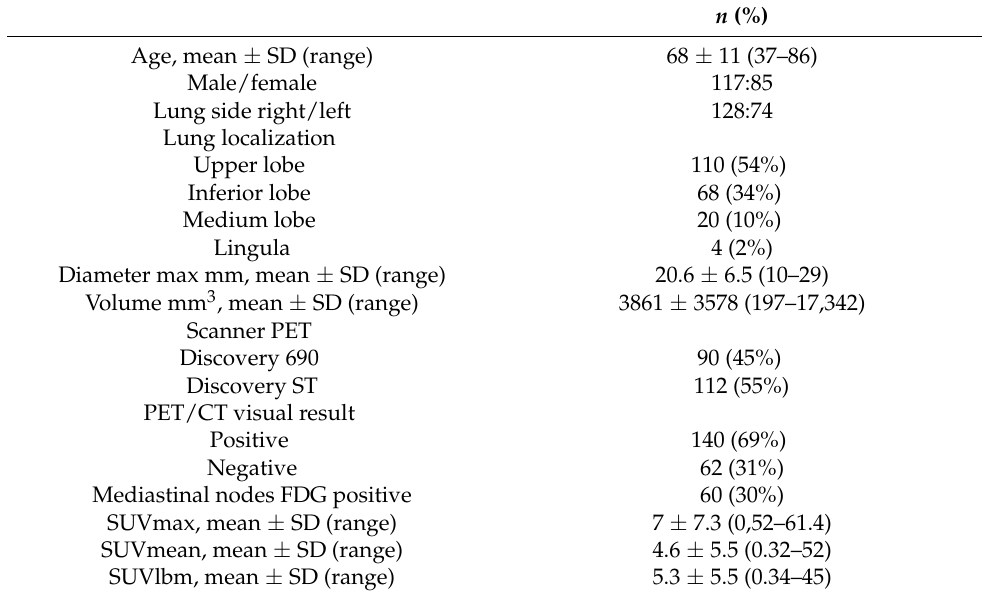
Table 1. The main features of the patients